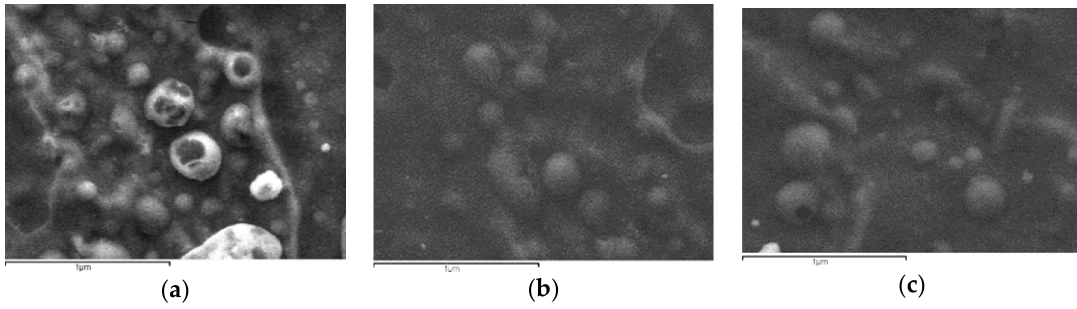
Figure 5. SEM micrographs of encapsulated drugs in ( a ) CS, ( b ) CS-AAMPS and ( c ) CS-MEDPS derivatives (scale bars are 1 μ m).